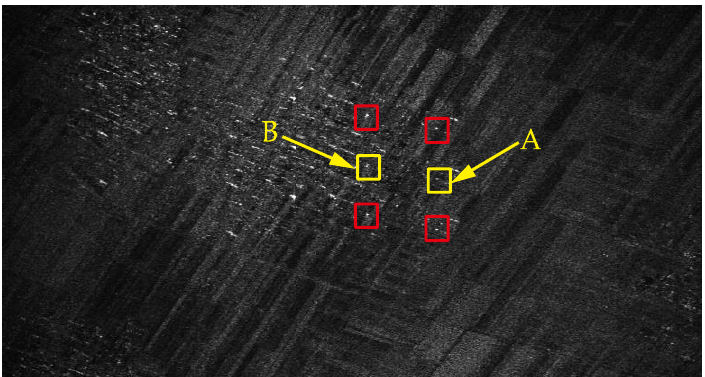
Figure 12. Single-channel undersampling imaging results.